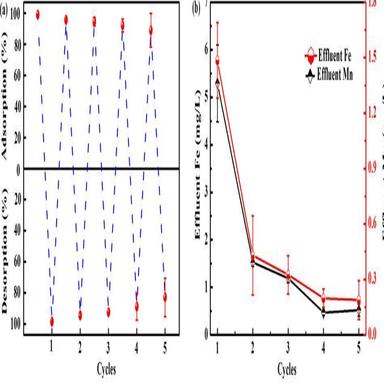
(a) Performance of regeneration and reuse of nZVIM using 0.01 mol/L HCl for five cycles; (b) leaching of iron and manganese during five reuse cycles.